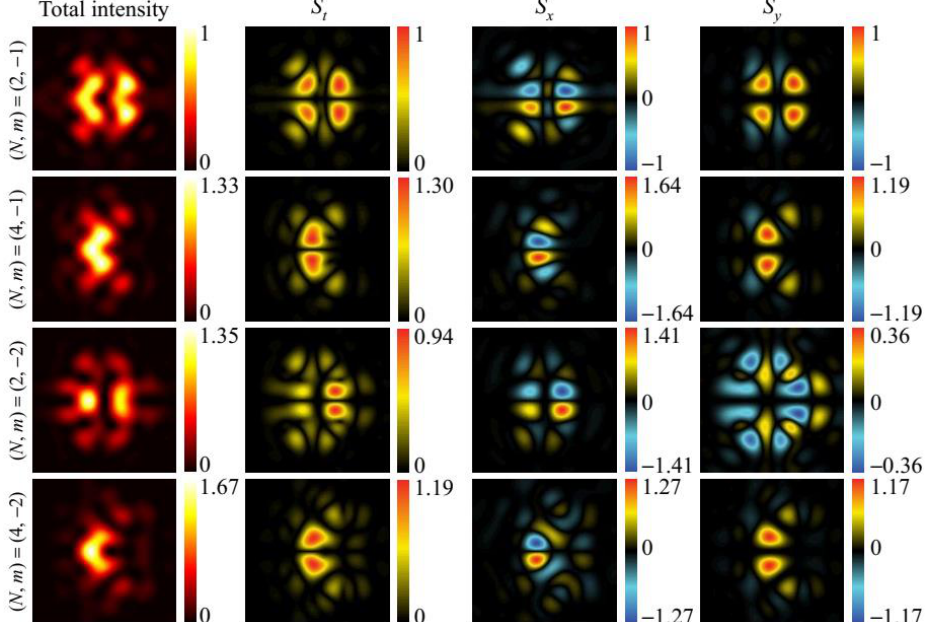
Figure 5. The total intensity and transverse SAM density of the tightly focused SM-HP-VOF when ( N , m ) = (2, − 1), (4, − 1), (2, − 2) and (4, − 2) in the four rows, respectively. The first column shows the total intensity of the tightly focused SM-HP-VOF. For the transverse SAM density, the transverse component S t , x -component S x , and y -component S y are shown in the second to fourth columns, respectively. The numerical aperture of the focal lens is NA = 0.95 , and any picture in the focal plane has a size of 4 λ × 4 λ , with λ being the wavelength.